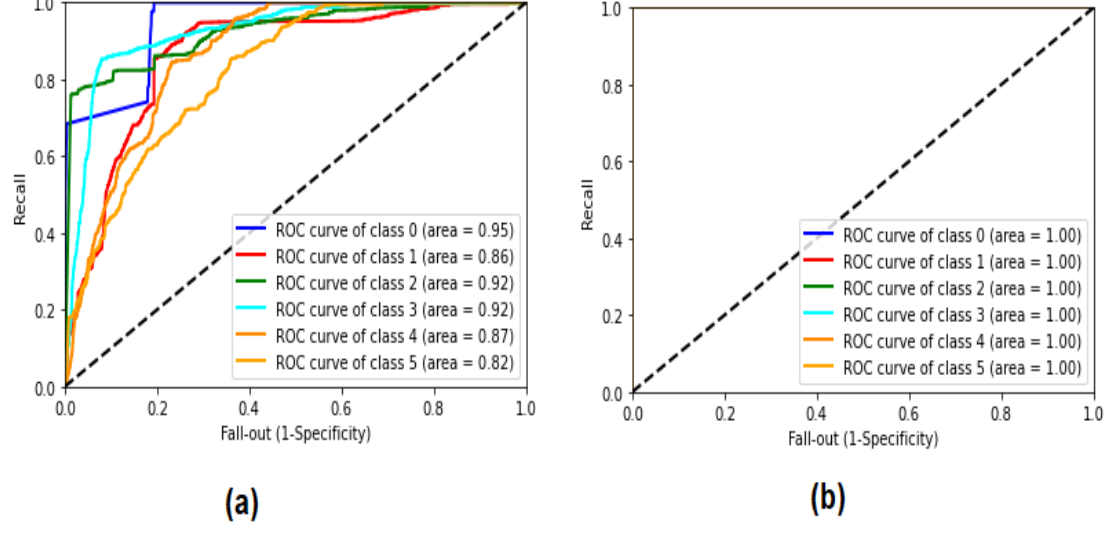
Figure 11. ROC of proposed system: ( a ) LSTM model; ( b ) CNN–LSTM model.